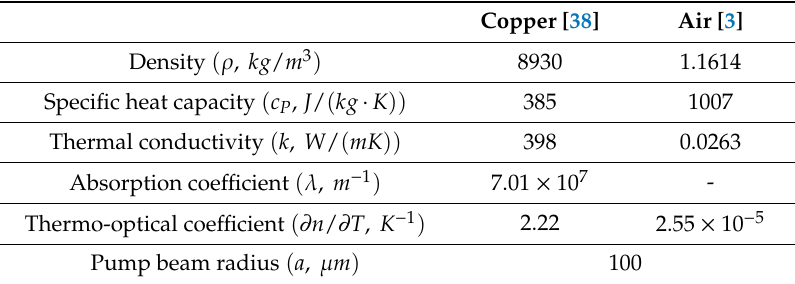
Table 3. Thermal properties for validation.